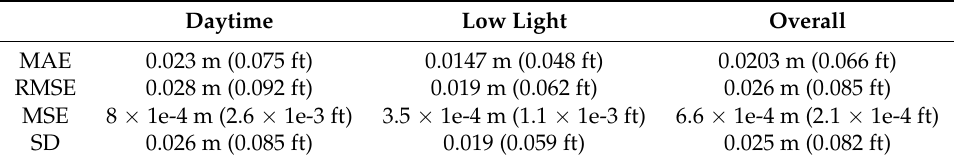
Table 1. Vehicle height measurement performance. MAE: Mean Absolute Error, RMSE: Root Mean Squared Error, MSE: Mean Squared Error, SD: Standard